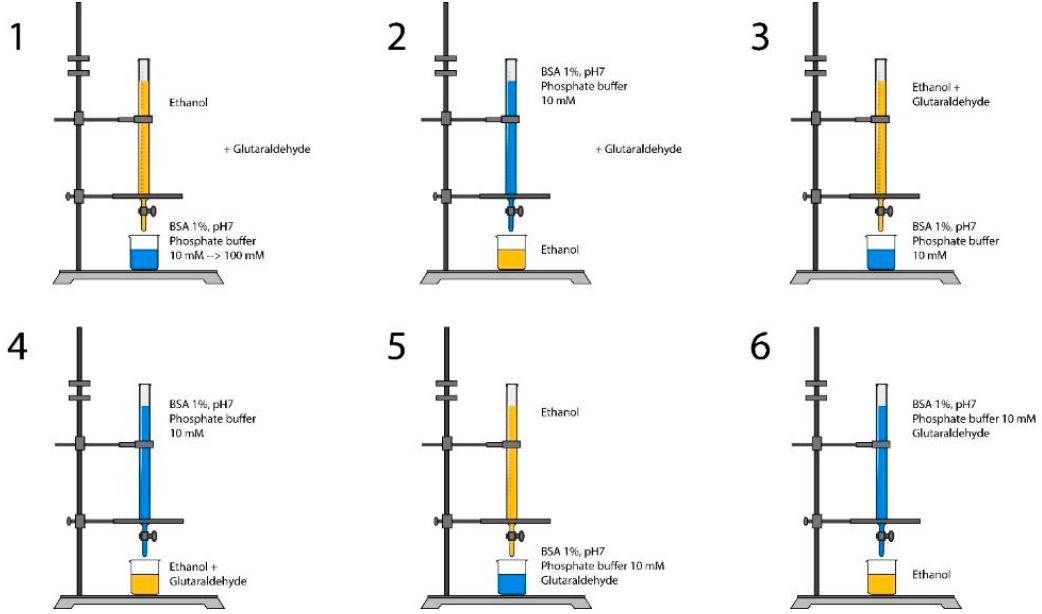
Figure 3. Different nanoprecipitation processes to prepare BSA nanoparticles. In 1 & 2, glutaraldehyde was added after the mixing of solvent and non-solvent together.